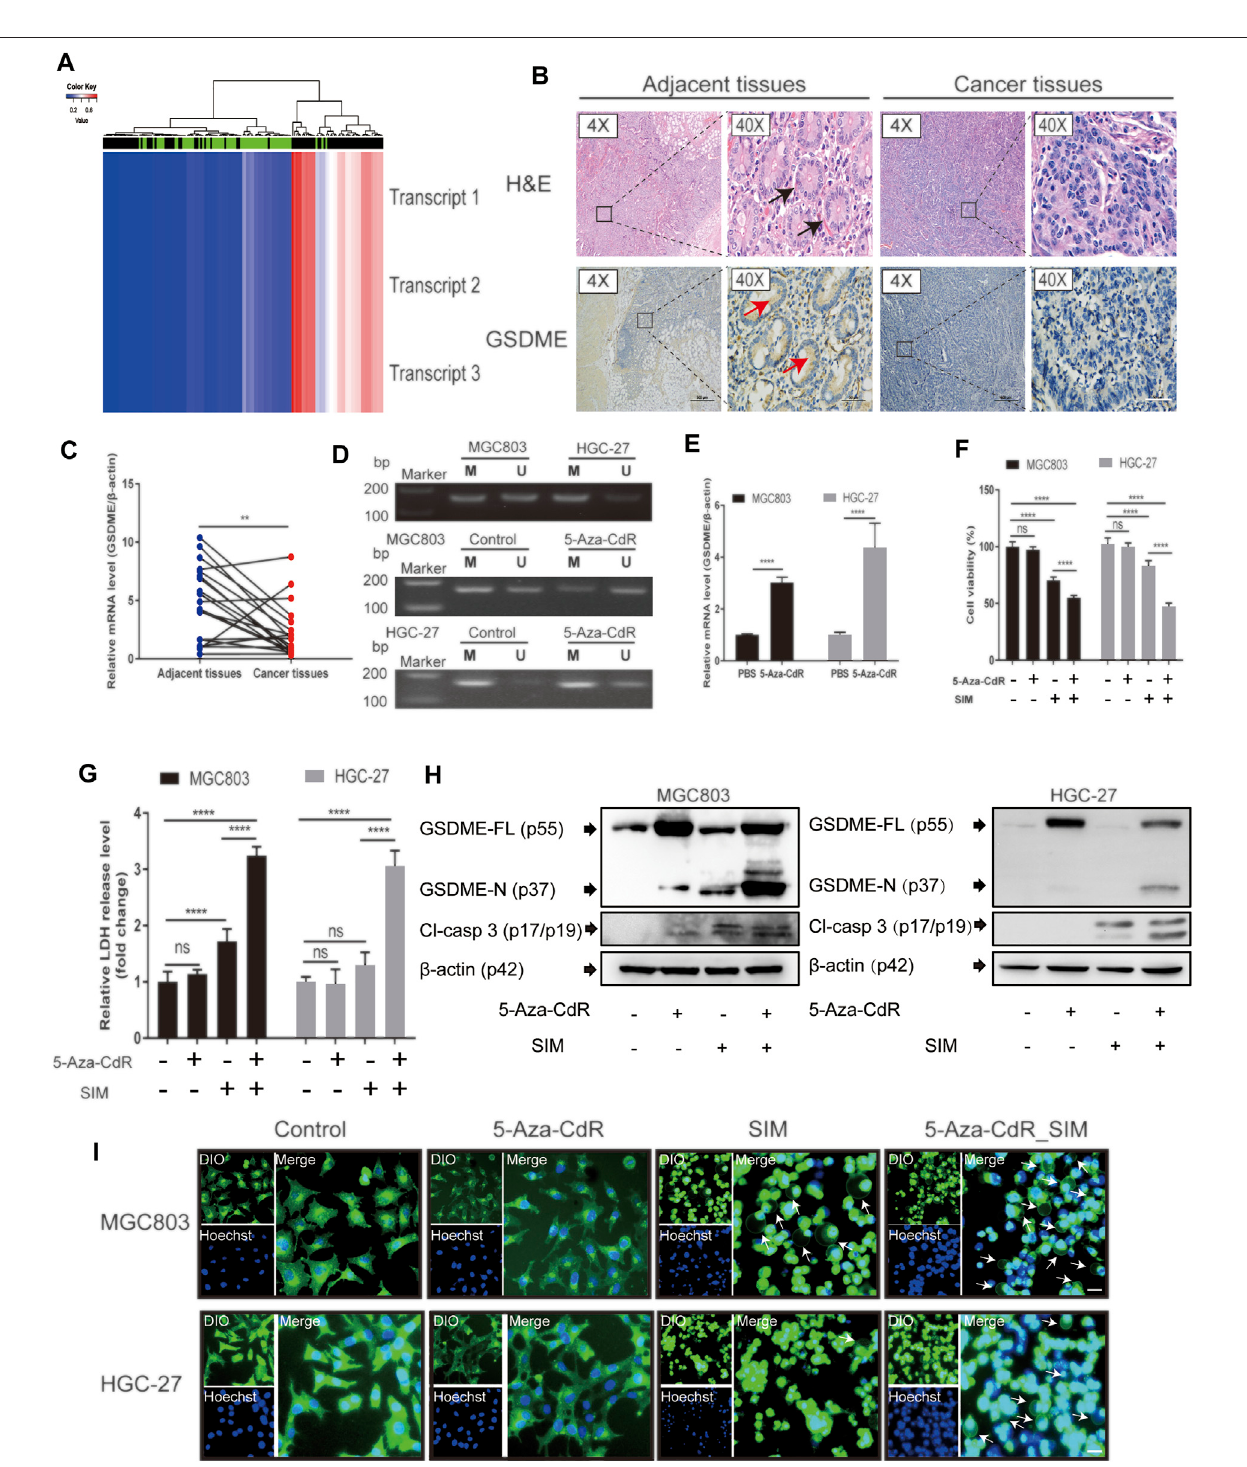
FIGURE 6 | Combination of SIM and 5-Aza-CdR enhances pyroptosis in GC. (A) The heatmap of GSDME methylation in GC. The heatmap contains methylation data of 3 transcripts from 141 samples of 27 k arrays. Rows represent transcripts and columns represent samples (green: normal pro fi les, black: disease pro fi les). (B) GSDME protein levels in human GCtissuesand adjacent tissues, detected immunohistochemically using HE staining; black arrows indicate complete gastric gland;red arrows indicate the IHC staining-positive cells; scale bar = 50 µm. (C) Relative GSDME mRNA expression in human GC tissues and adjacent normal tissues, determined by RT-qPCR ( n = 20). (D) MSP pro fi les of GSDME promoter methylation status in MGC-803 and HGC-27 cell before and after a daily dosing of 5-Aza-CdR for 72 h, M, methylated; U, unmethylated. After SIM treatment w/wo 5-Aza-CdR pre-dosing, (E) GSDME gene, (F) Cell viability, (G) LDH release, (H) protein cleavage of GSDMEandcaspase-3,and (I) fl uorescencemicroscopyoftheMGC-803andHGC-27cellsexamined.Dataareshownasmean±SDorrepresentativesofatleastthree independent experiments. β -actin was used as an internal control for Western blot. pppp p < 0.0001 and p > 0.05; ns, not signi fi cant.